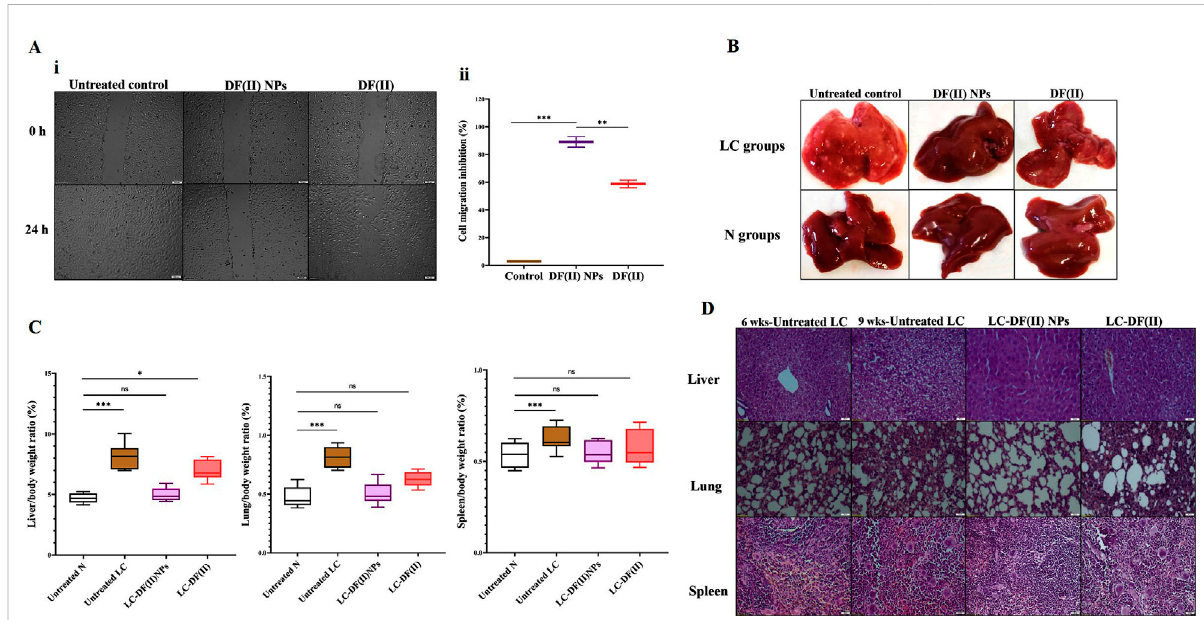
FIGURE 2 In vitro anti-migration potential and in vivo anti-liver cancer ef fi cacy (morphology, weight, and histochemical assessments) using chemically induced animal model (A) Anti-migration activity as illustrated by (I) microscopic images of migration (at 0 and 24 h) of the untreated and DF(II) complexes-treatedHepG2cellsand (II) migrationinhibitionpercentages.Dataareshownasmean±SEM.DF(II)NPs-treatedcellswerecomparedto the untreated and DF(II) complexes-treated cells, considering statistically signi fi cant at p ≤ 0.05*, ≤ 0.005**, and ≤ 0.001***. (B) Macroscopic images of liver morphology of all studied groups (C) Relative liver, lung, and spleen weights to body weight in the untreated and DF(II) complexes- treated liver cancer (LC) groups, compared to healthy (N) group. Data are shown as mean ± SEM. Healthy N group was compared to the untreated and DF(II) complexes-treated LC groups, considering statistically signi fi cant at p ≤ 0.05*, ≤ 0.005**, and ≤ 0.001*** (C) H&E-staining liver, lung, and spleen tissues of the untreated LC group, at the 6th week of LC induction (showing neoplasia in liver, small section of lung cancer cells without modi fi cations in spleen) and at the 9th of LC induction (declaring a characterized anaplasia (clear cell hepatocellular carcinoma, expanded area of lung cancer, and lymphoid hyperplasia in spleen), and DF(II) complexes-treated LC groups (3 weeks of treatment), disclosing stronger therapeutic ef fi cacy of DF(II) NPs than DF for eradicating LC cells with halting metastasis to lung or